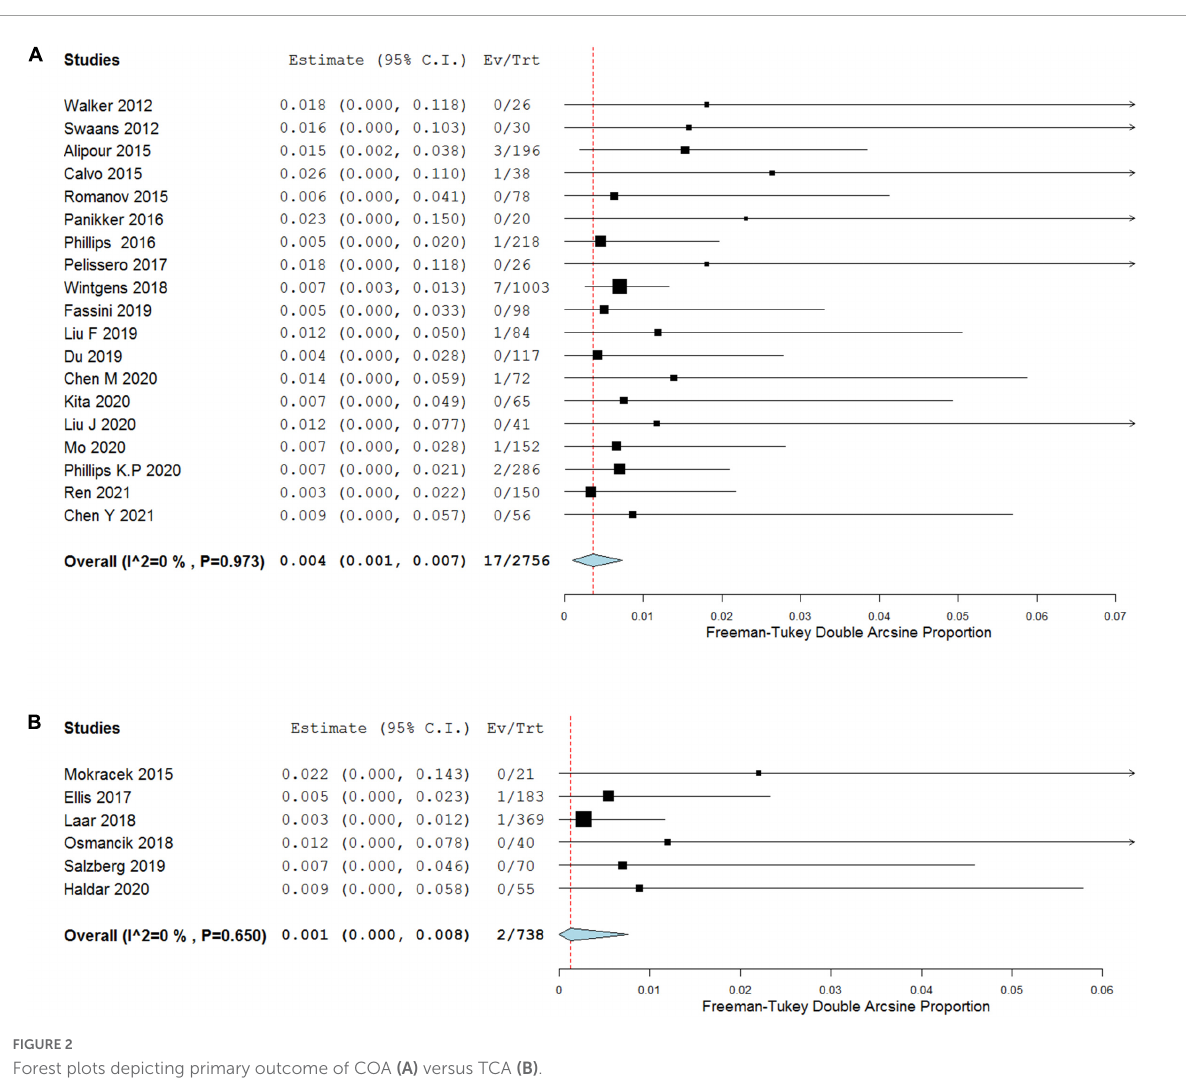
FIGURE2 Forest plots depicting primary outcome of COA (A) versus TCA (B) .